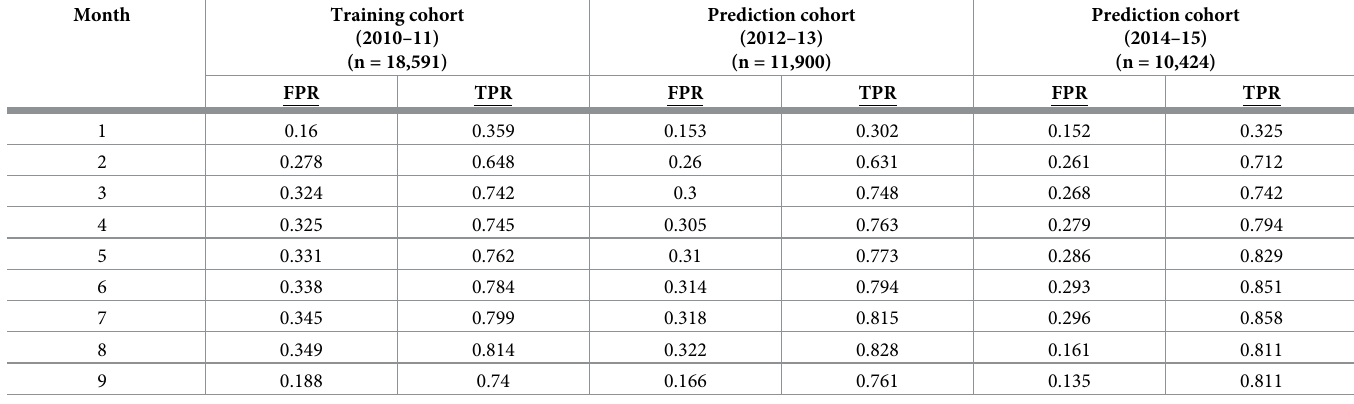
Table 4. Accuracy metrics of future cohorts, using a 0.15 PPGM cutoff threshold, and a 6-month moving window to identify patients at risk of sustained prescrip- tion opioid